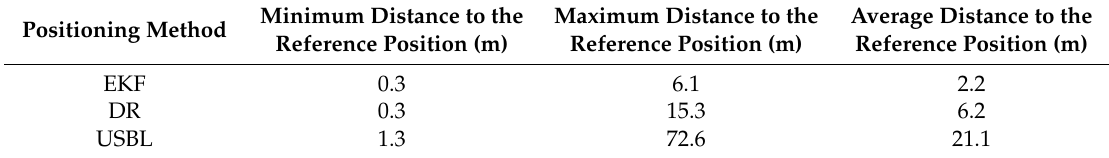
Table 7. Statistical parameters of positioning errors using EKF and DR methods and the USBL system (single passage).